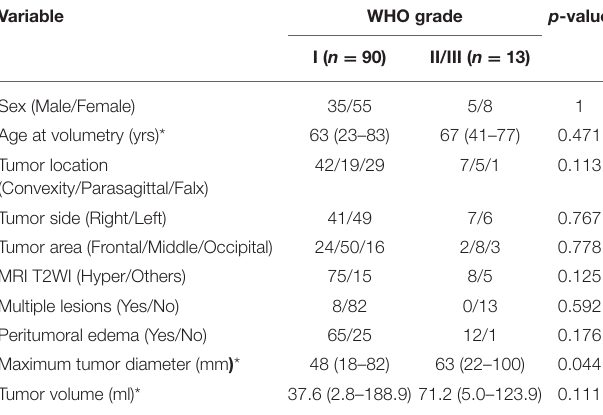
TABLE 5 | Comparison of WHO grade I and grade II/III meningioma.